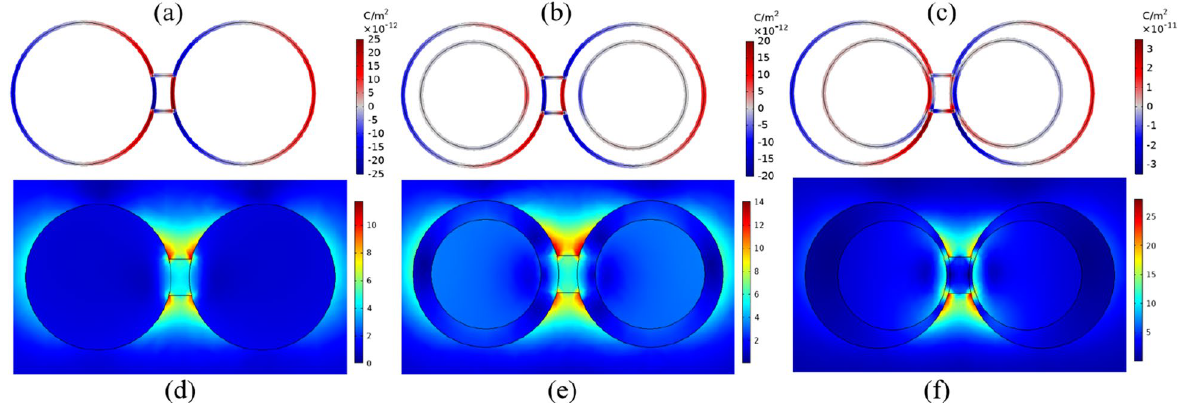
Figure 4. Top panel: Surface Charge distribution of SBDP mode of ( a ) SSBD ( b ) CSBD, ( c ) NEBD. Red color represents positive charge while blue is negative. Bottom panel: E-field maps of the bridged dimer calculated at SBDP. ( d ) SSBD at (cid:31) SBDP = 522 nm , ( e ) CSBD at (cid:31) SBDP = 581 nm and ( f ) NEBD at (cid:31) SBDP = 605 nm